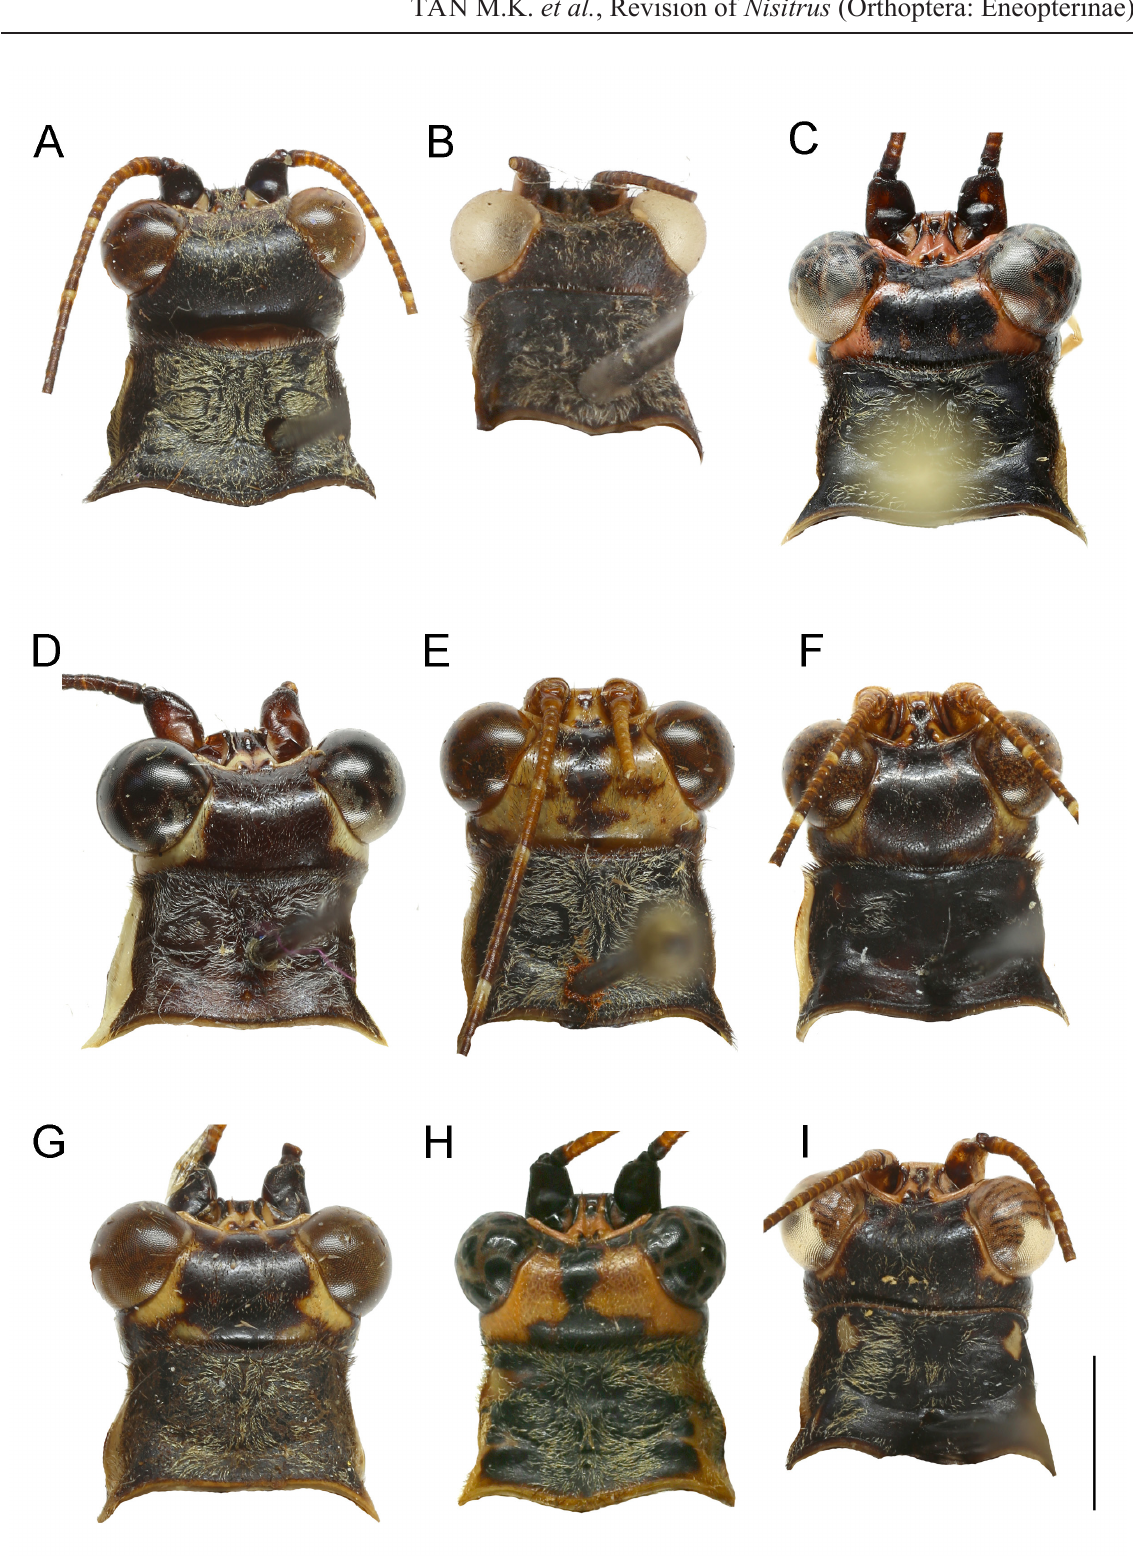
Fig. 11. Head and pronotum in dorsal view. A . Nisitrus brunnerianus Saussure, 1878. B . N. crucius Robillard & Tan sp. nov. C . N. danum Robillard & Tan sp. nov. D . N. hughtani Robillard & Tan sp. nov. E . N. insignis Saussure, 1878. F . N. malaya Robillard & Tan sp. nov. G . N. musicus Ingrisch, 1987. H . N. rindu Robillard & Tan sp. nov. I . N. vittatus (Haan, 1844). Scale bar = 2